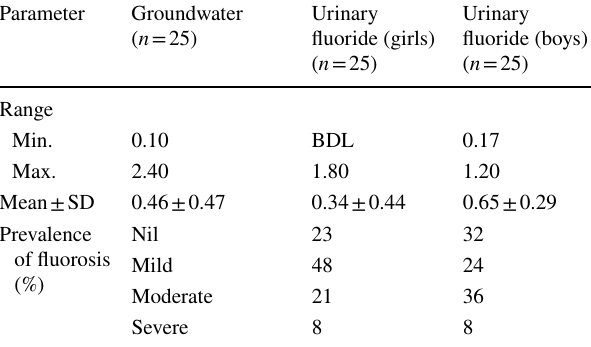
Table 1 Concentration of fluoride in ground water and urine, and prevalence of fluorosis among school children in Bass village